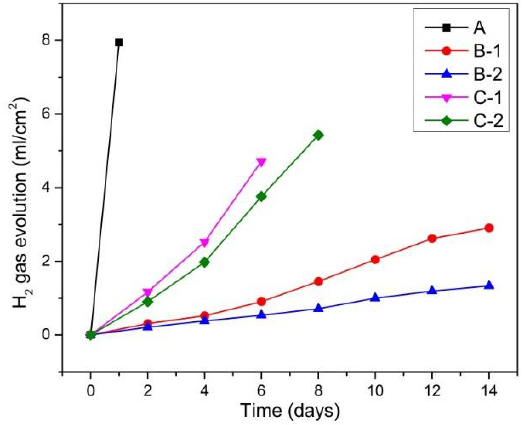
Figure 4. Hydrogen gas evolution during immersion test.